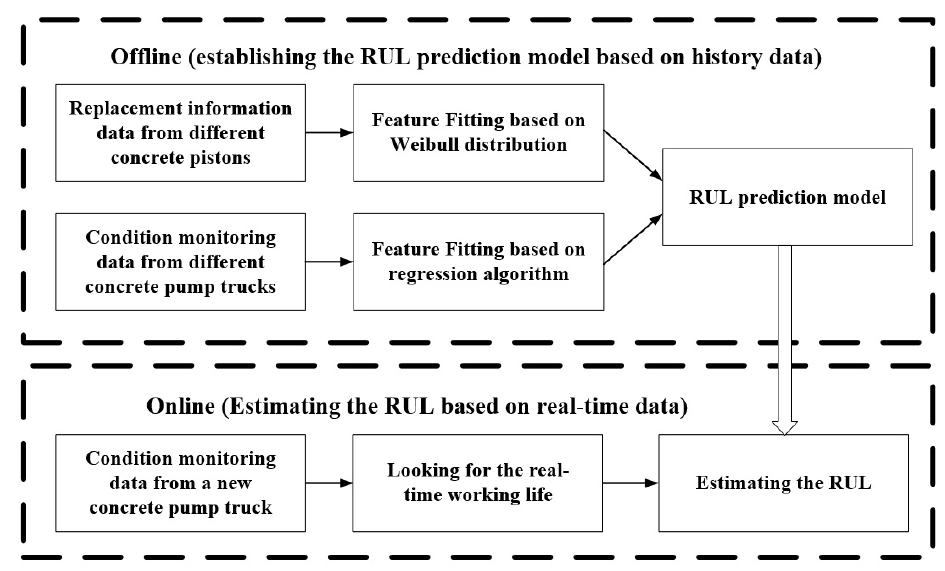
Figure 2. Flowchart of the RUL prediction.